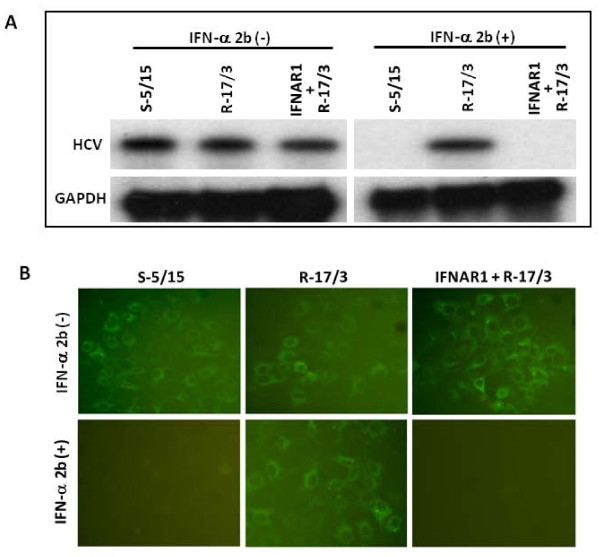
Stable expression of IFNAR1 improves the antiviral response of IFN-α in resistant R-17/3 cells. Cured Huh-7 cells prepared from S-5/15 and R-17/3 cells were transfected with full-length JFH1-GFP chimeric HCV RNA by electroporation. After 72 hours, these cells were treated with IFN-α (1000 IU/ml) for an additional 72 hours. Replication of HCV in the transfected cells was examined by GFP expression and positive-strand HCV-RNA was detected by RPA using a probe targeted to the highly conserved 5'UTR. (A) HCV RNA levels before and after IFN-α treatment was measured by RPA. Left panel shows that high level HCV RNA replication in different Huh-7 clones without IFN-α treatment. Right panel shows the HCV RNA level in the same set of Huh-7 cell lines after IFN-α treatment. IFN-α inhibits the level of HCV RNA in IFN-α sensitive Huh-7 cells, but not in the resistant Huh-7 cell line. The antiviral effect of IFN-α can be restored upon stable expression of IFNAR1 in the resistant Huh-7 cell line. The GAPDH mRNA levels served as controls. (B) Expression and replication of HCV-GFP in the transfected Huh-7 cells before and after IFN-α treatment was measured by fluorescence microscopy at 20X magnification. The upper panel shows the expression HCV-GFP chimera protein in different Huh-7 cell lines transfected with HCV without IFN-α treatment. The lower panel shows the expression HCV-GFP in the same set of Huh-7 cells after IFN-α treatment. Positive expression indicates the impaired antiviral effect of IFN-α against HCV.